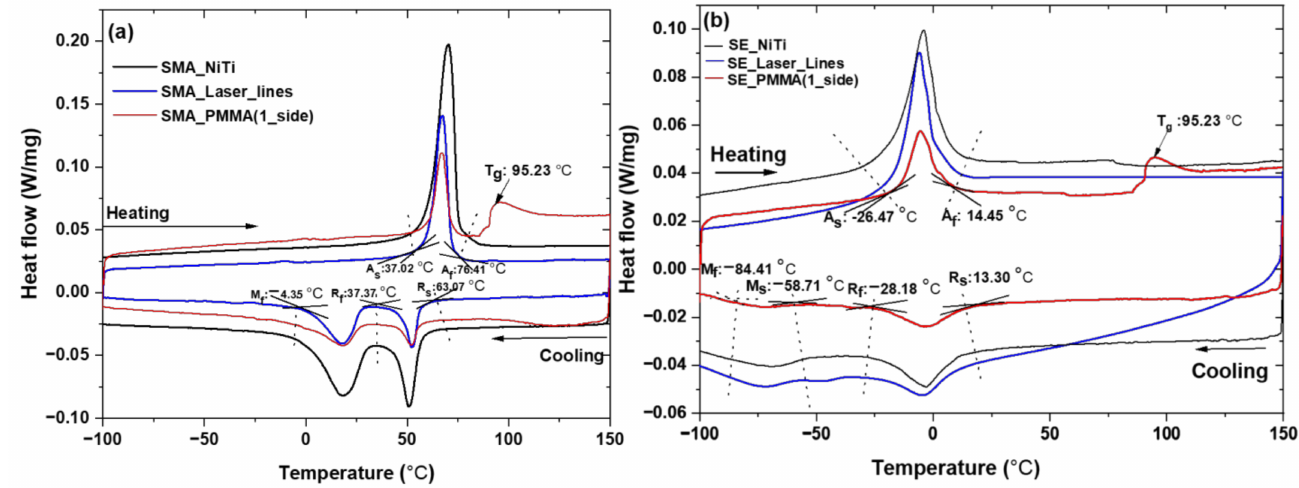
Figure 4. DSC curves ( a ) SMA, SMA_Laser_lines, SMA_PMMA (1_side), SE, and ( b ) SE_Laser_lines for SE_ PMMA (1_side)